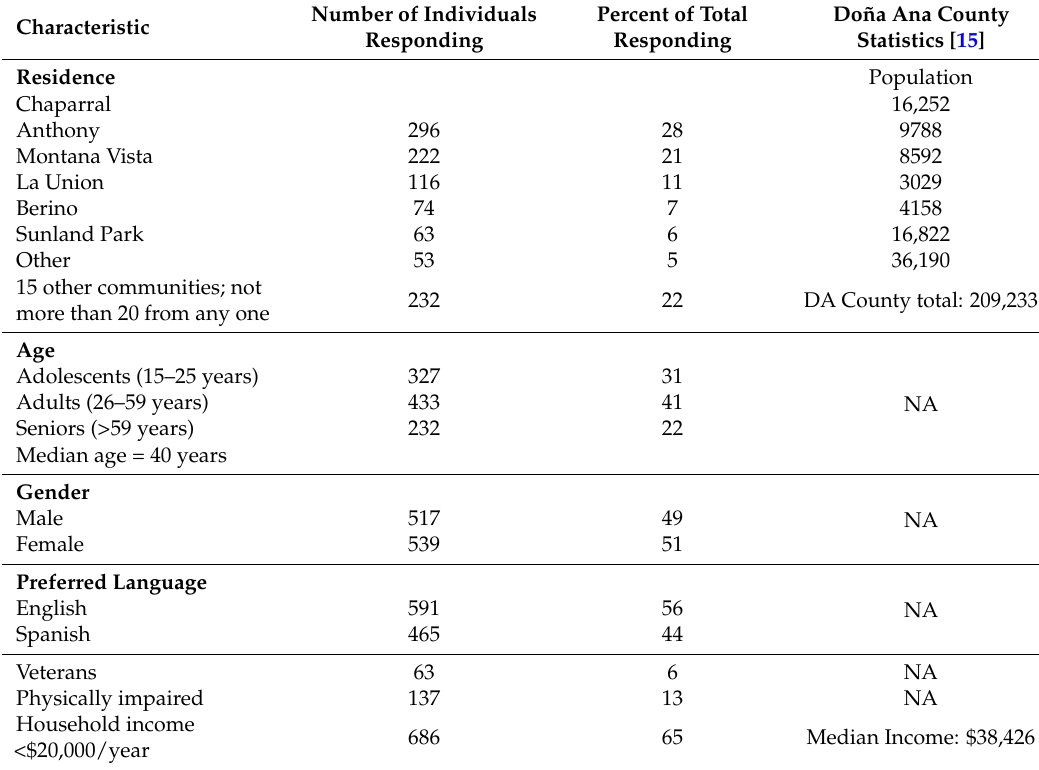
Table 1. Demographics of survey